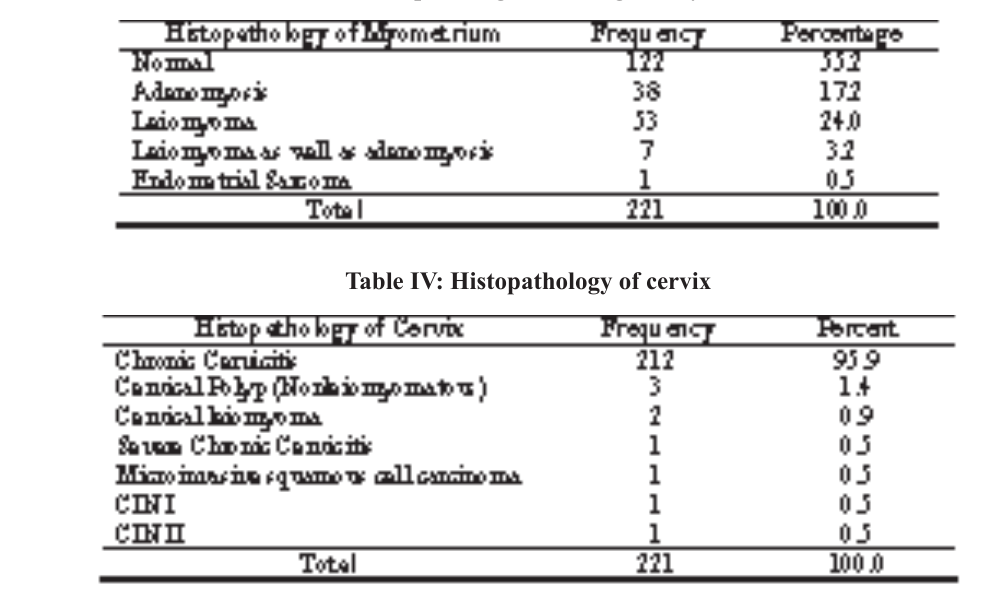
Table III: Histopathological findings